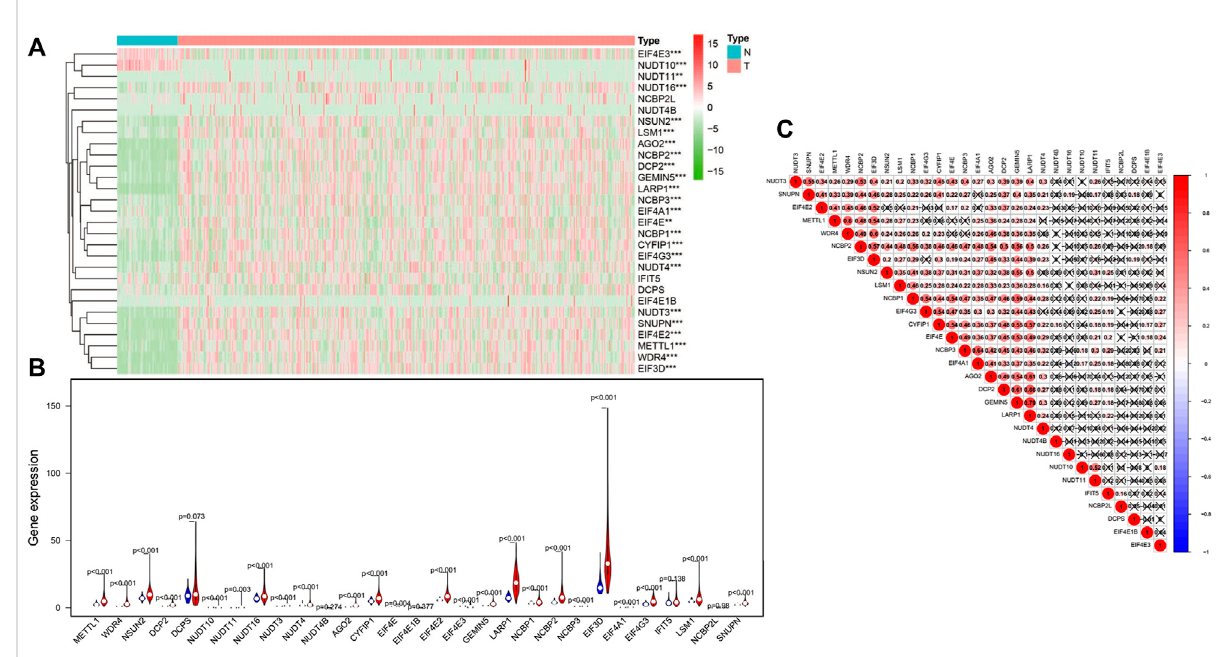
FIGURE 1 The levels of m 7 Gmodi fi cationregulators inhepatocellularcarcinoma (HCC). (A) The heatmap shows themRNA level ofm 7 G RNAmodi fi cation regulatorsineachsample. “ N ” representsnormalsample,and “ T ” representscancersample.Greenstandsforlowexpressions,andredstandsforhigh expressions. (B) The vioplot shows the differential regulators of m 7 G RNA modi fi cation in HCC. Blue stands for normal samples, and red stands for HCC samples. White spots indicate the median value of the expression. (C) Spearman correlation analyses of 29 m 7 G RNA modi fi cation regulators in HCC. *** p <